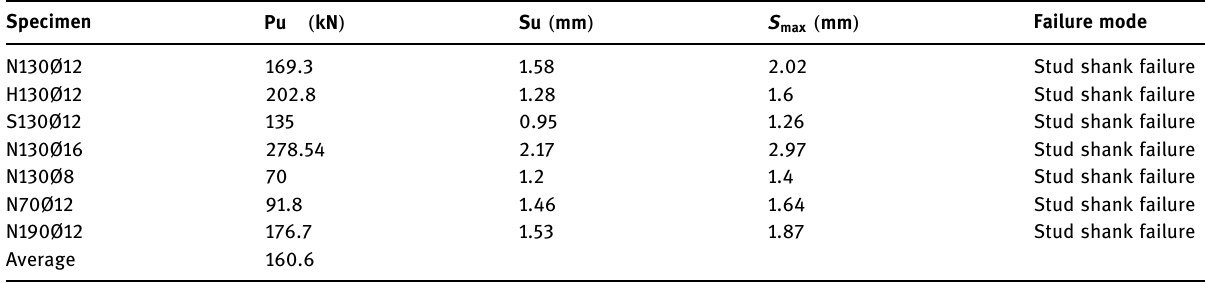
Table 5: Pushout test results for group I rough surface specimen